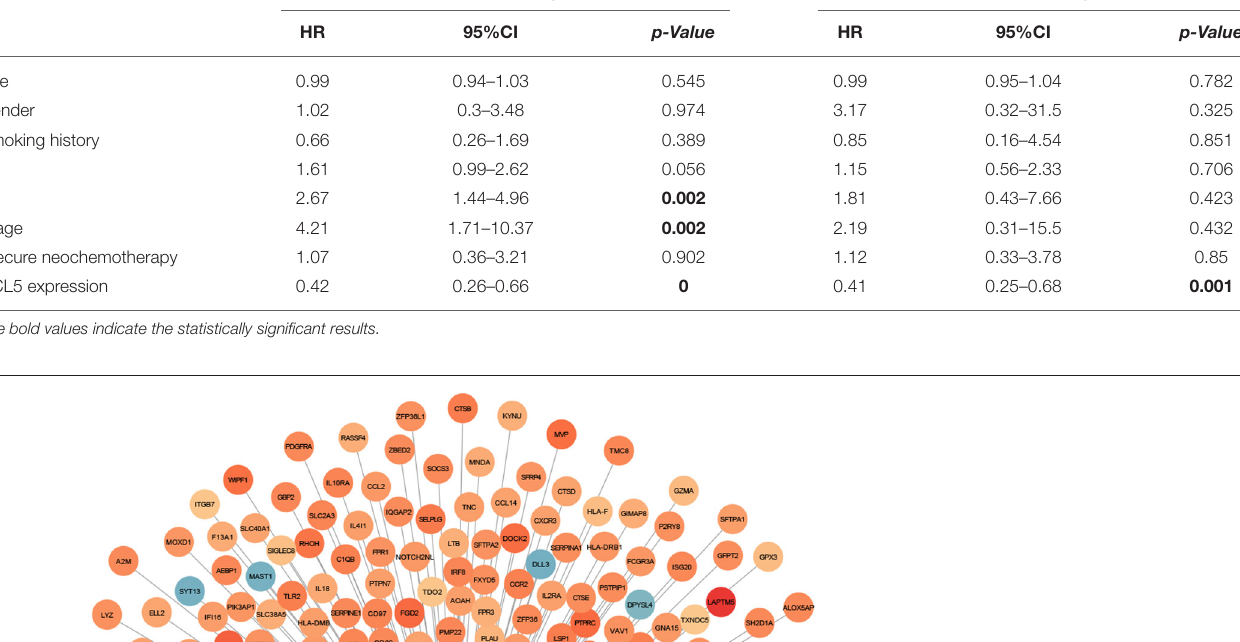
TABLE 1 | Univariate Cox model and Multivariate Cox regression model in the Jiang study. Clinical characteristic Univariate analysis Multivariate analysis